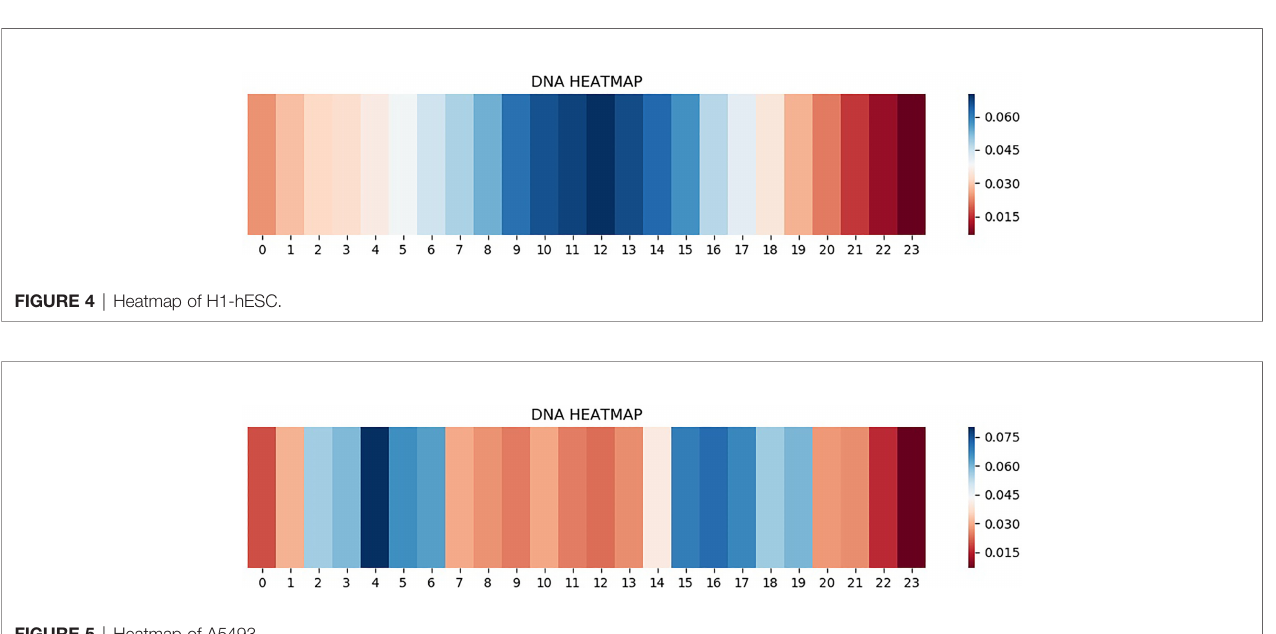
FIGURE 5 | Heatmap of